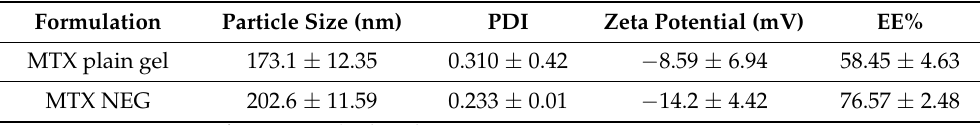
Table 4. Characterization of MTX nanogel